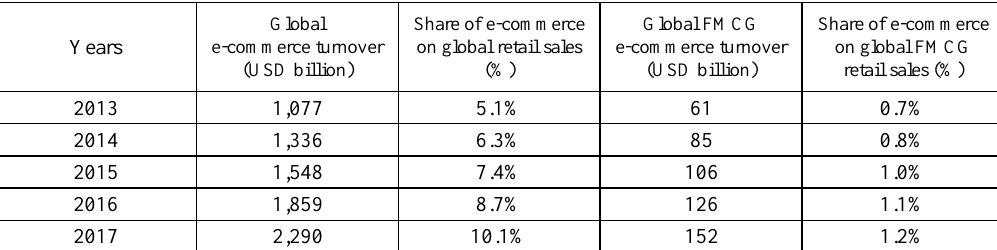
Table 1: Global e-commerce turnover and market share 2013-2017 Global Years e-commerce turnover (USD